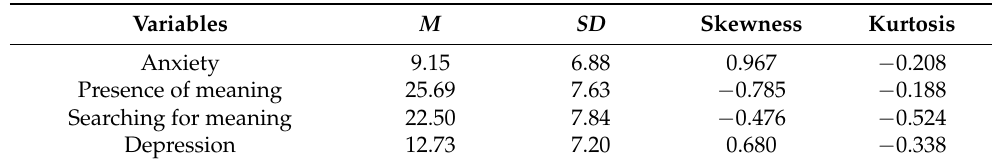
Table 1. Descriptive statistics for anxiety, presence of meaning, searching for meaning, and depression ( N = 277). Variables